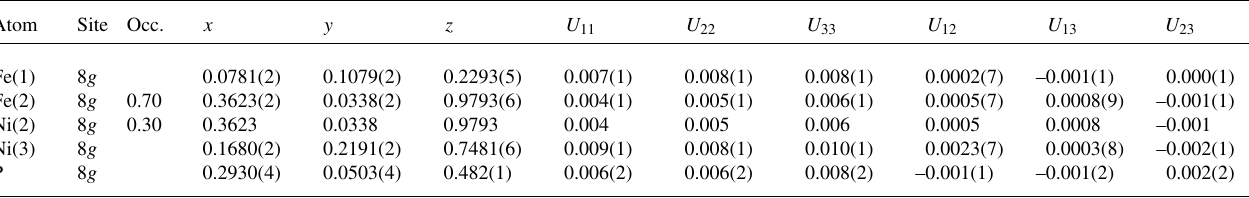
Table 2. Atomic coordinates and displacement parameters (in Å 2 ) . Atom Site